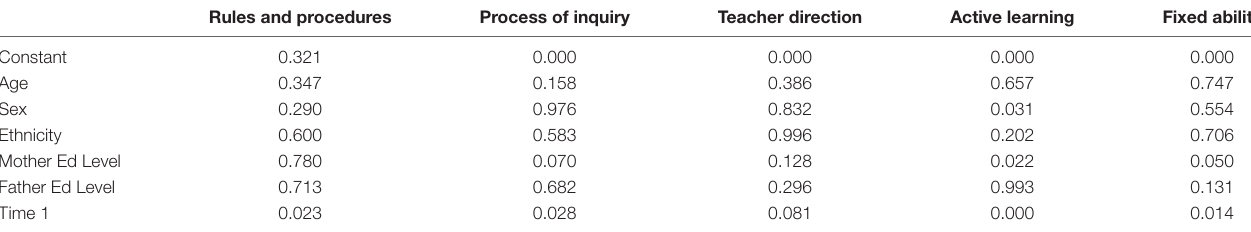
TABLE 7 | Linear regression Time 1 to Time 3 with fixed ability as the dependent variable.